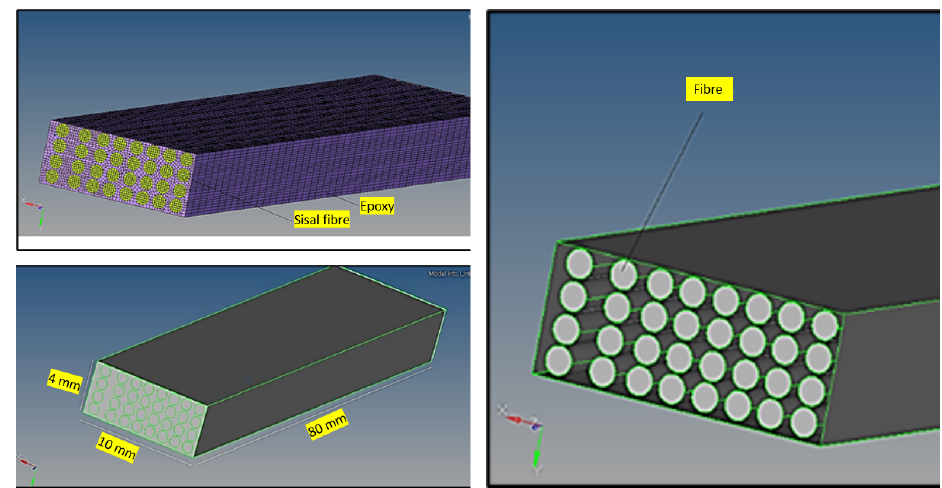
Figure 12. Different stages of model development in ANSYS. Table 5. Property materials utilized in ANSYS [46].